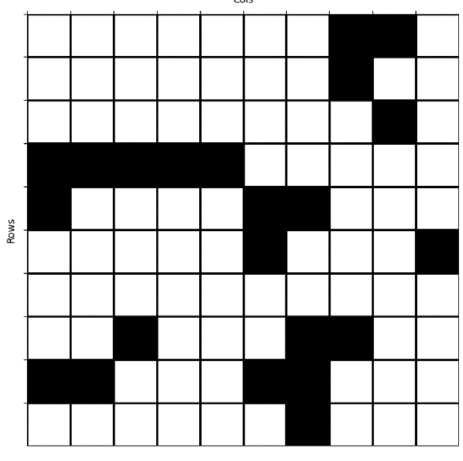
Figure 3. An example of a grid map.